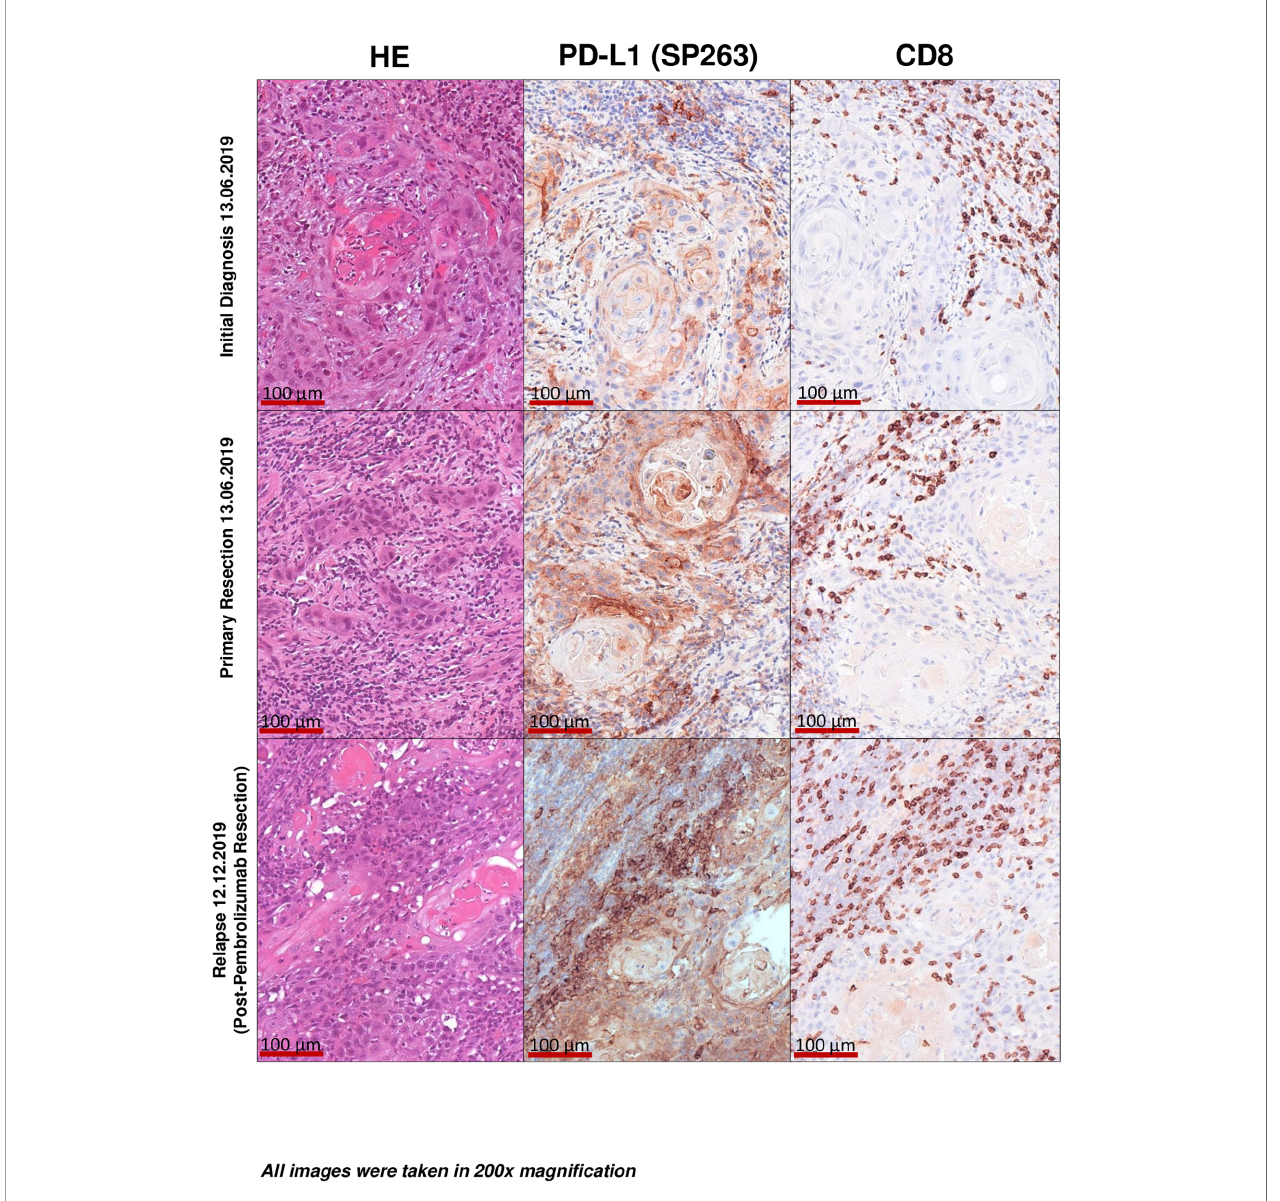
FIGURE 2 | Histopathological imaging. Initial diagnosis. Primary resection. Final post-pembrolizumab resection specimen of tumour recurrence. Images taken at 200× magni fi cation. Histological fi ndings proving a signi fi cantly higher CD8+ positive T-Cell density after PD-L1 antibody use in the form of Pembrolizumab may be indicative of the patients signi fi cantly improved immunologic status. In addition, continued postoperative use could have a positive impact on the likelihood of a second